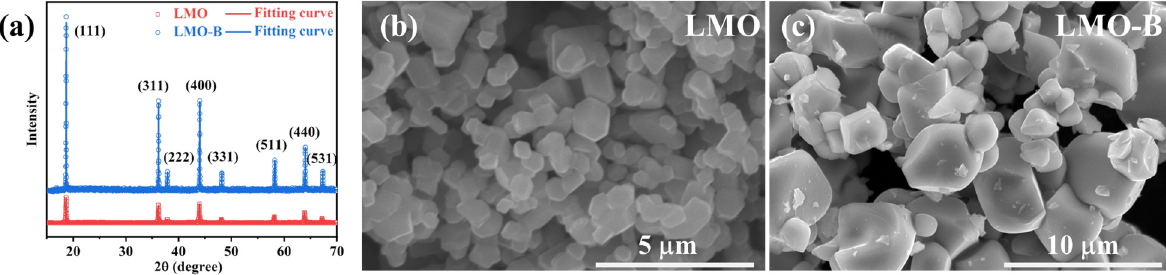
Figure 1. ( a ) XRD patterns of the LMO and LMO-B samples; the SEM images of the ( b ) LMO and ( c ) LMO-B.